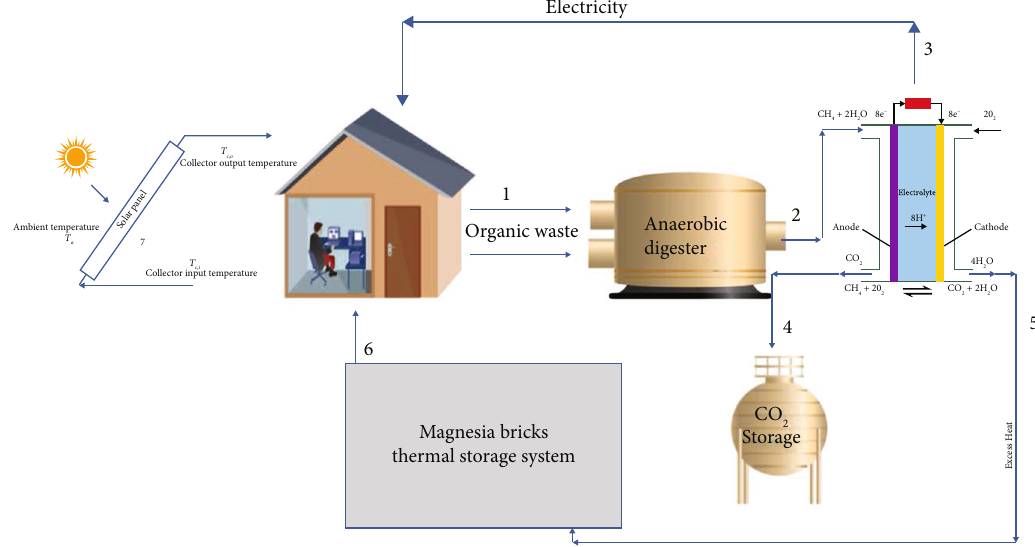
Figure 1: Proposed system: day cycle (1, 2, 3, 4, 5, and 7) and night cycle (1, 2, 3, 4, 5, and